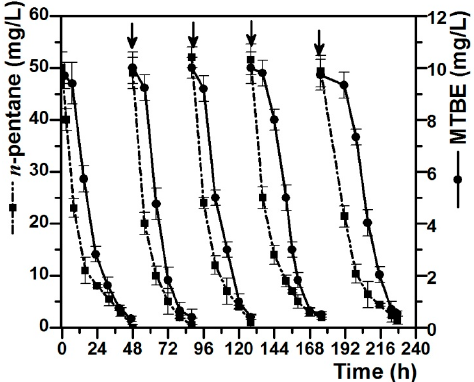
Figure 3. Co-metabolic degradation of MTBE with n -pentane as growth substrate. Vertical arrows indicate the additions of MTBE and n -pentane. MTBE (10 mg/L) and n -pentane (50 mg/L) were re-spiked when the residual concentrations of both MTBE and n -pentane in the cultures were below 5% of the initial concentrations. All of the values are the means of triplicate.